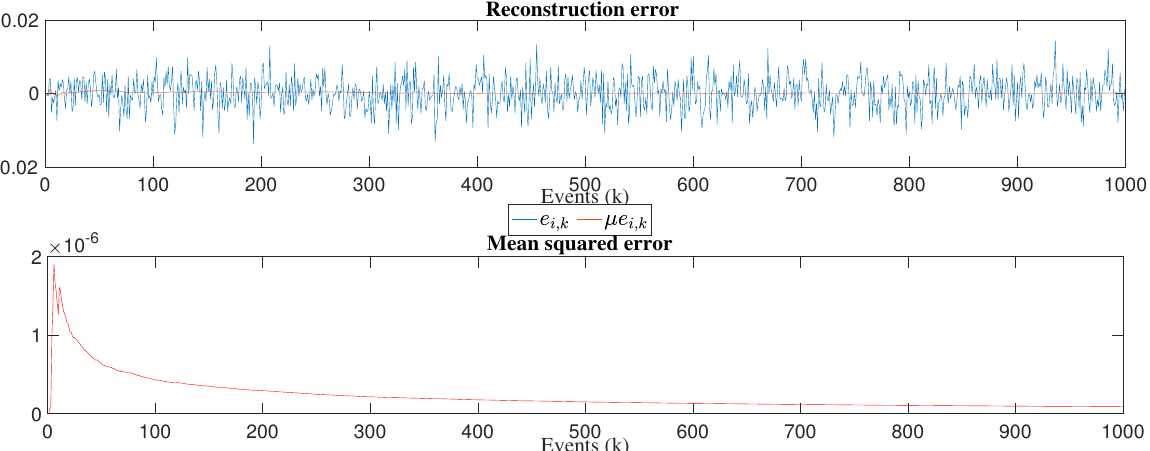
Figure 14. Graph of the reconstruction error and mean squared error for the 32 × 32 matrix inversion experiment.